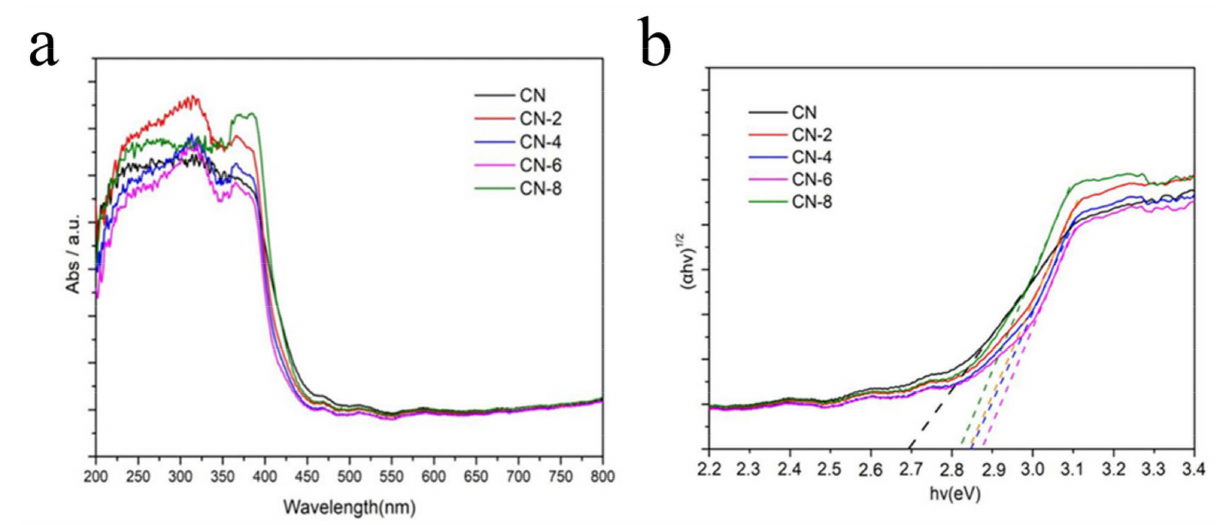
Figure 7. UV–vis/DRS of CN and CN-6 ( a ) and the corresponding band gap plots ( b